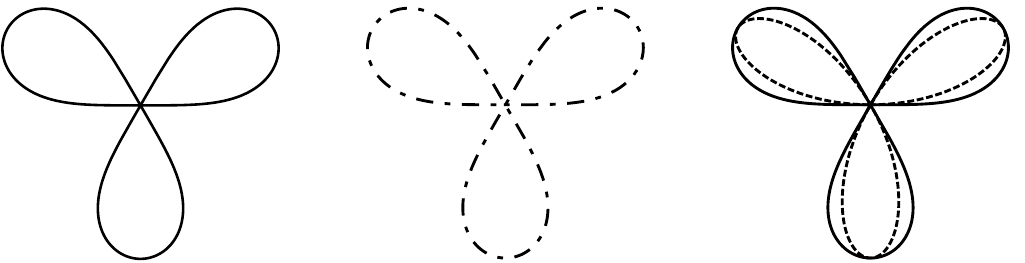
Figure 3. The first two graphics here represent the Kiepert trefoils drawn via Equations (30) (solid curve) and (38) (dashed line) with the same a , while the third one illustrates the difference between the Kiepert trefoil (solid curve) and the trefoil associated with Equation (3) (after rotation of